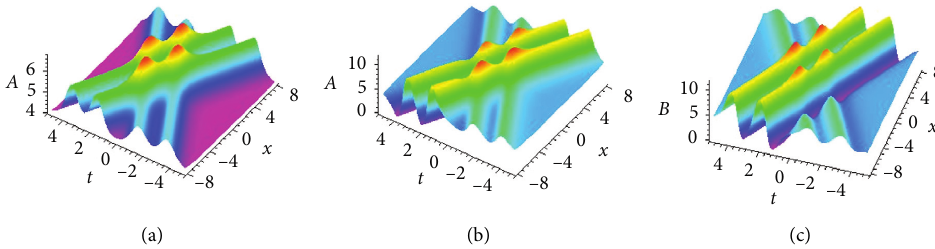
Figure 6: The four-soliton solution (32) with (a) b